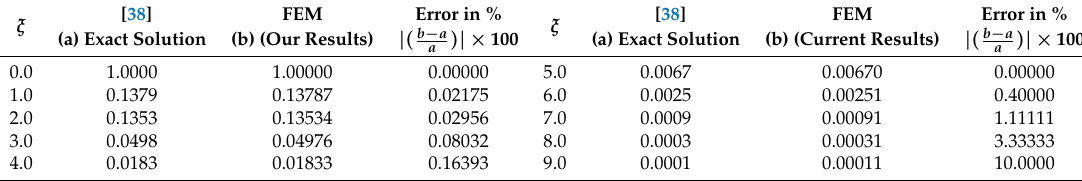
Table 3. Comparison of the f (cid:48) ( η ) with the published results of Crane [38]. ξ